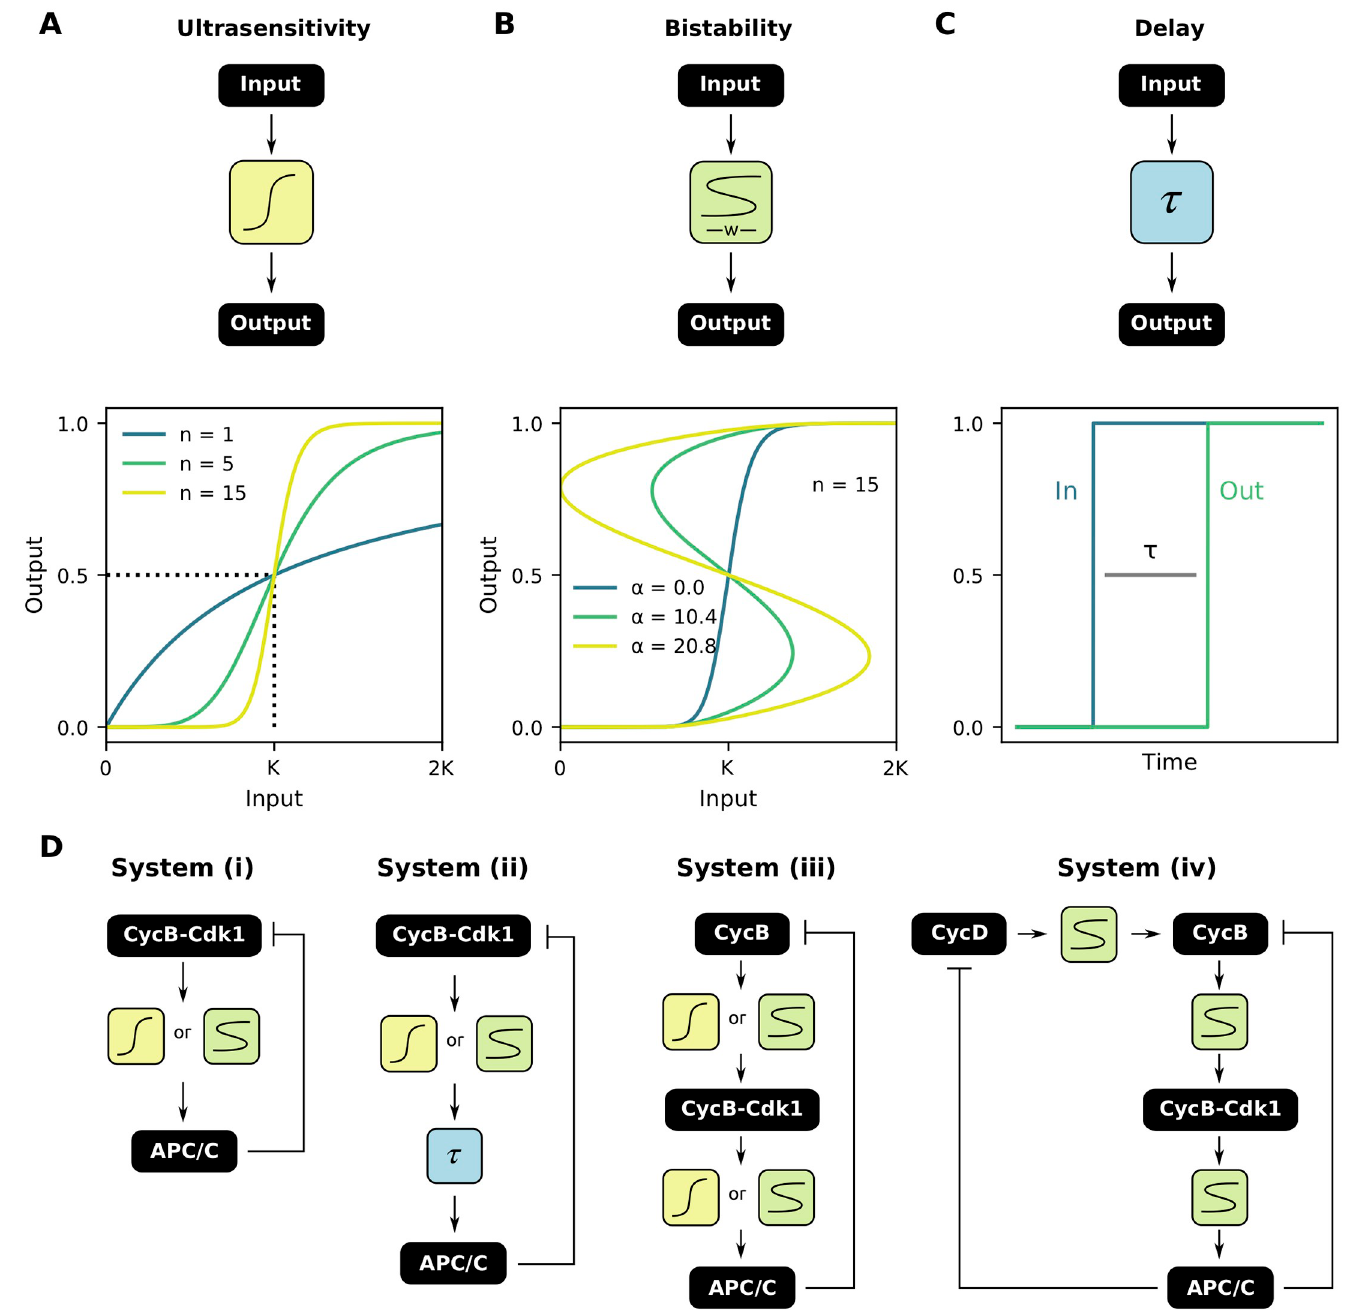
Fig 2. Ultrasensitive responses, S-shaped responses and delay as functional modules. (A) An ultrasensitive input-output response is characterized by the threshold value K and the Hill exponent n . (B) An ultrasensitive function can be converted into an S-shaped response of different widths: for α = 0, an ultrasensitive response is obtained, while increasing α increases the width of the S-shaped region. These plots were generated by calculating the inverse of Eq 1. (C) A certain lag time τ between input and output is encountered in several biochemical reactions. (D) Several combinations of the three functional modules, always in the presence of negative feedback, to describe oscillations in the cell